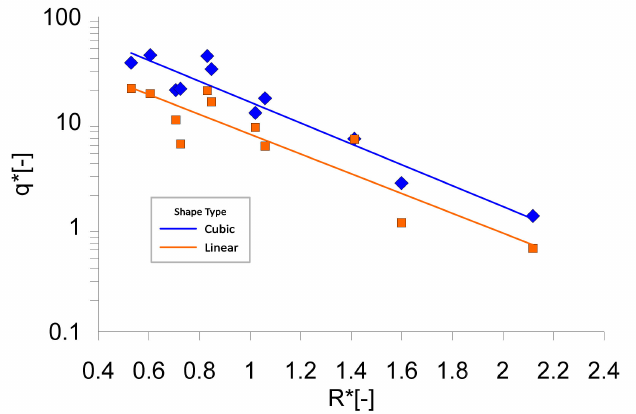
Figure 18. Comparison of non-dimensional overtopping discharge between cubic and linear shapes.